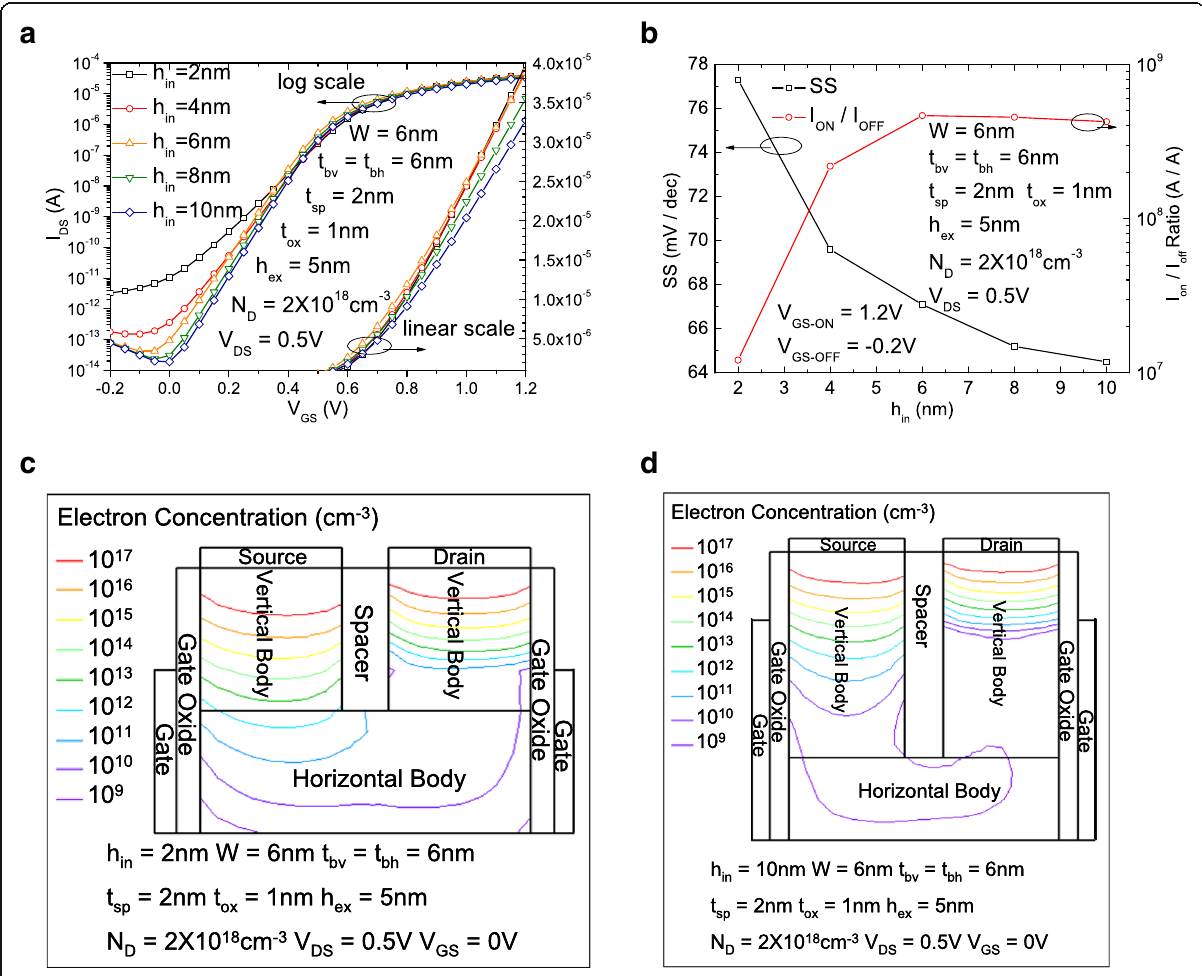
Fig. 2 a The comparisons of the I DS - V GS characteristics of the RGUC FET with different h in s on both logarithmic and linear scales. b The comparisons of subthreshold swings (SS) and I ON / I OFF ratio of the RGUC FET with different h in s. c 2-D electron concentration distribution in the silicon body in off state for the device with 2-nm h in . d 2-D electron concentration distribution in the silicon body in off state for the device with 10 nm h